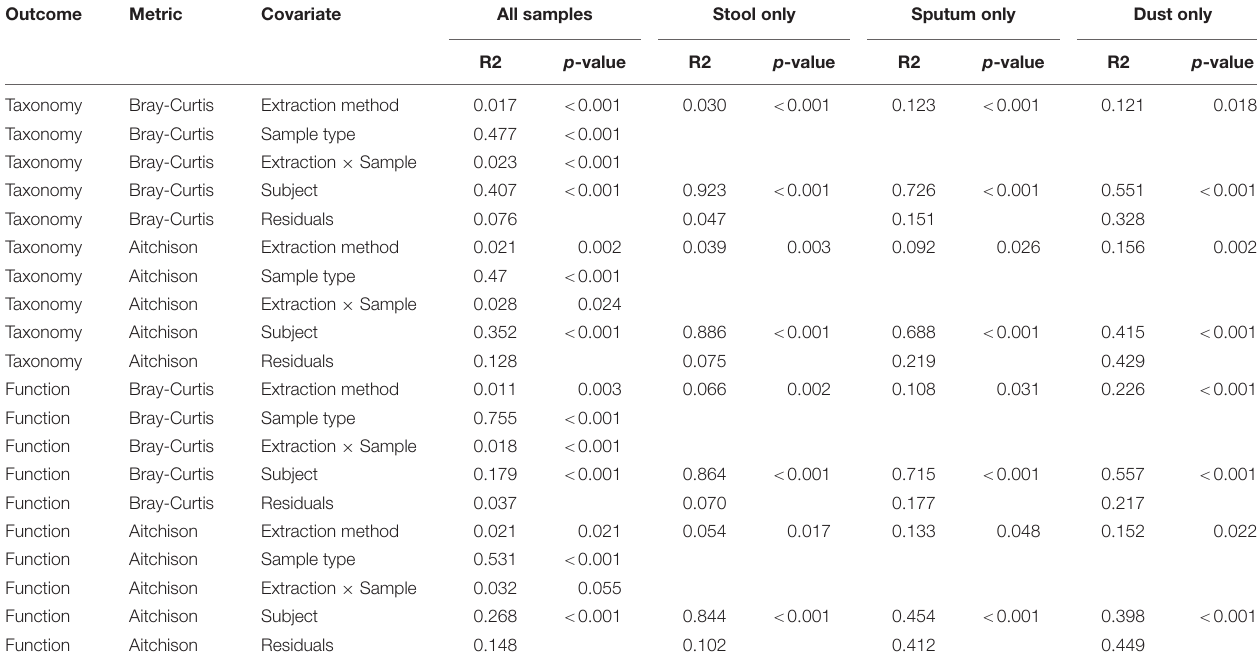
TABLE 4 | Permutational analysis of variance to determine influence of extraction method on microbial communities (both taxonomy and predicted function) stratified by sample